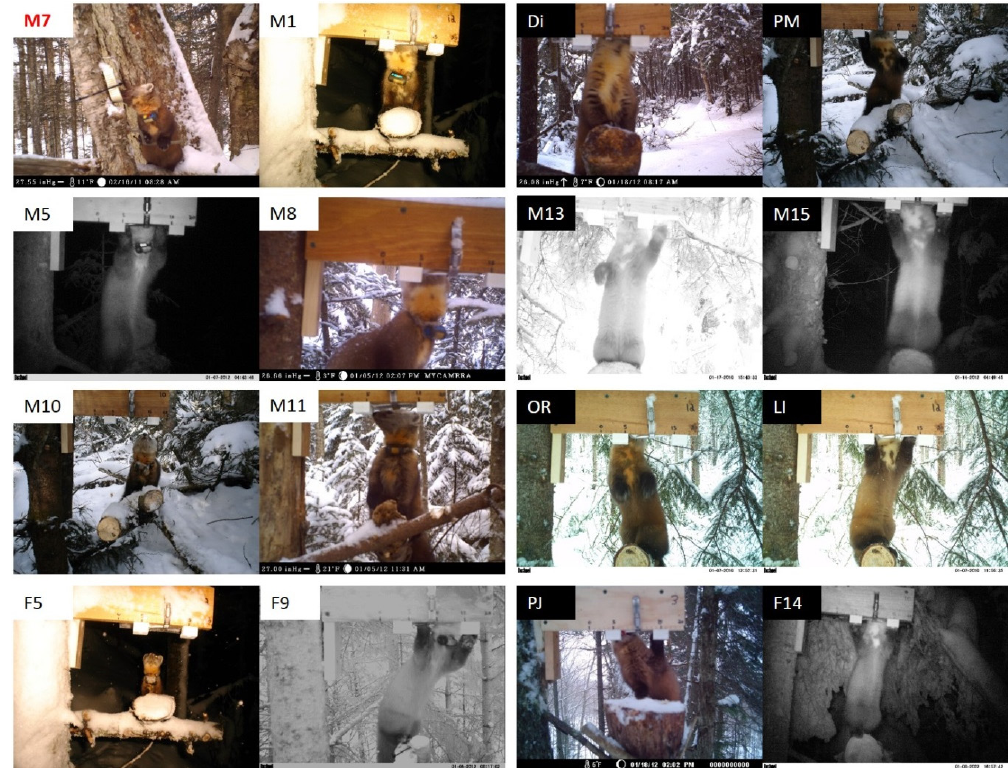
Figure 3. Ventral patches of seven collared ( left ; black font) and eight un ‐ collared ( right ; white font) martens photographed during camera ‐ trapping from 3–21 January 2012 in northern New